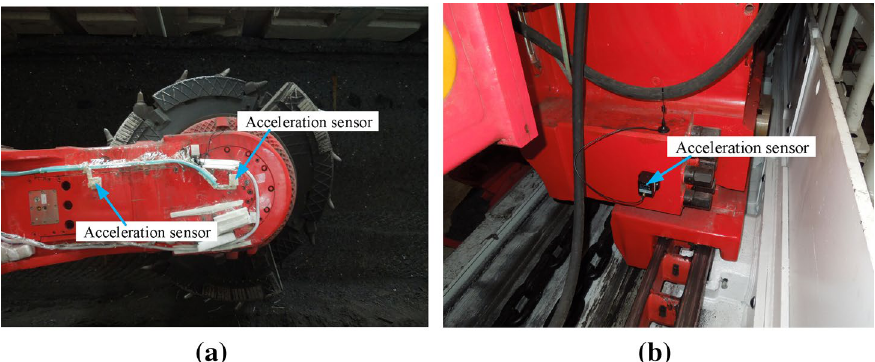
Figure 11. The installation position of the vibration acceleration sensor of the rocker arm and the walking box, for rocker arm (left) and drum (right) ( a ) and walking box ( b